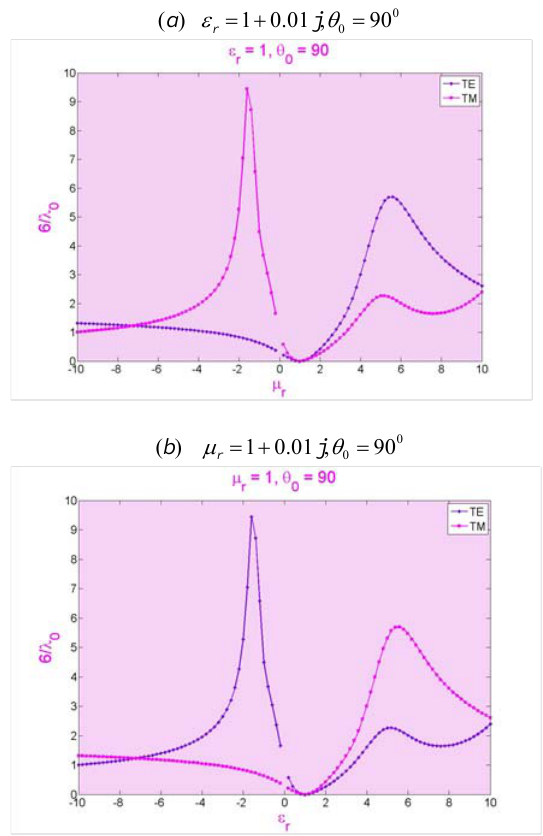
Figure 5: Normalized monostatic echo width of cylinder (a=5mm, f=1 GH) for transparency conditions or RCS